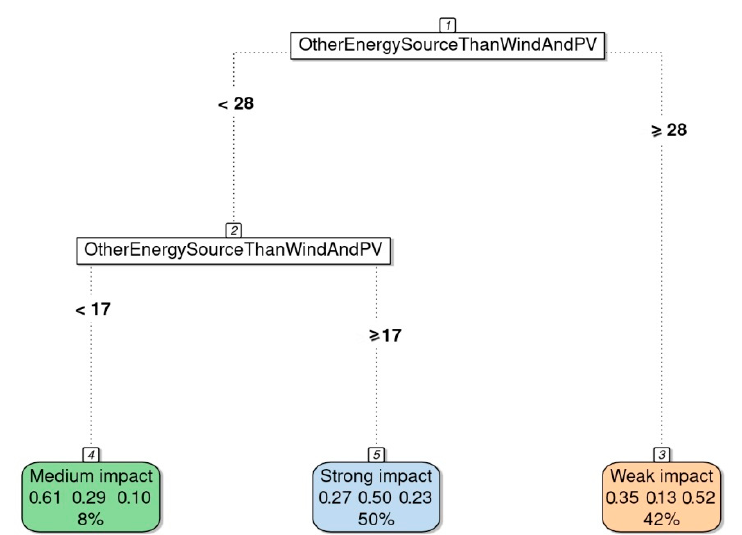
Figure 5. Simulation results in the regression-tree modeling without a variable specifying the number of cooperative members.